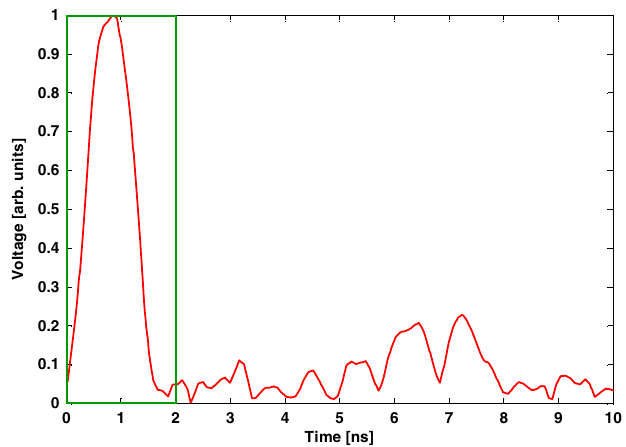
FIG. 11. Schematic pulse shape for